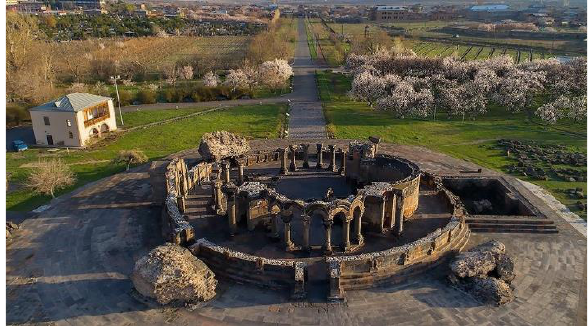
Figure 3. Cathedral of Zvartnots. ©Andranik Keshishyan 2017.